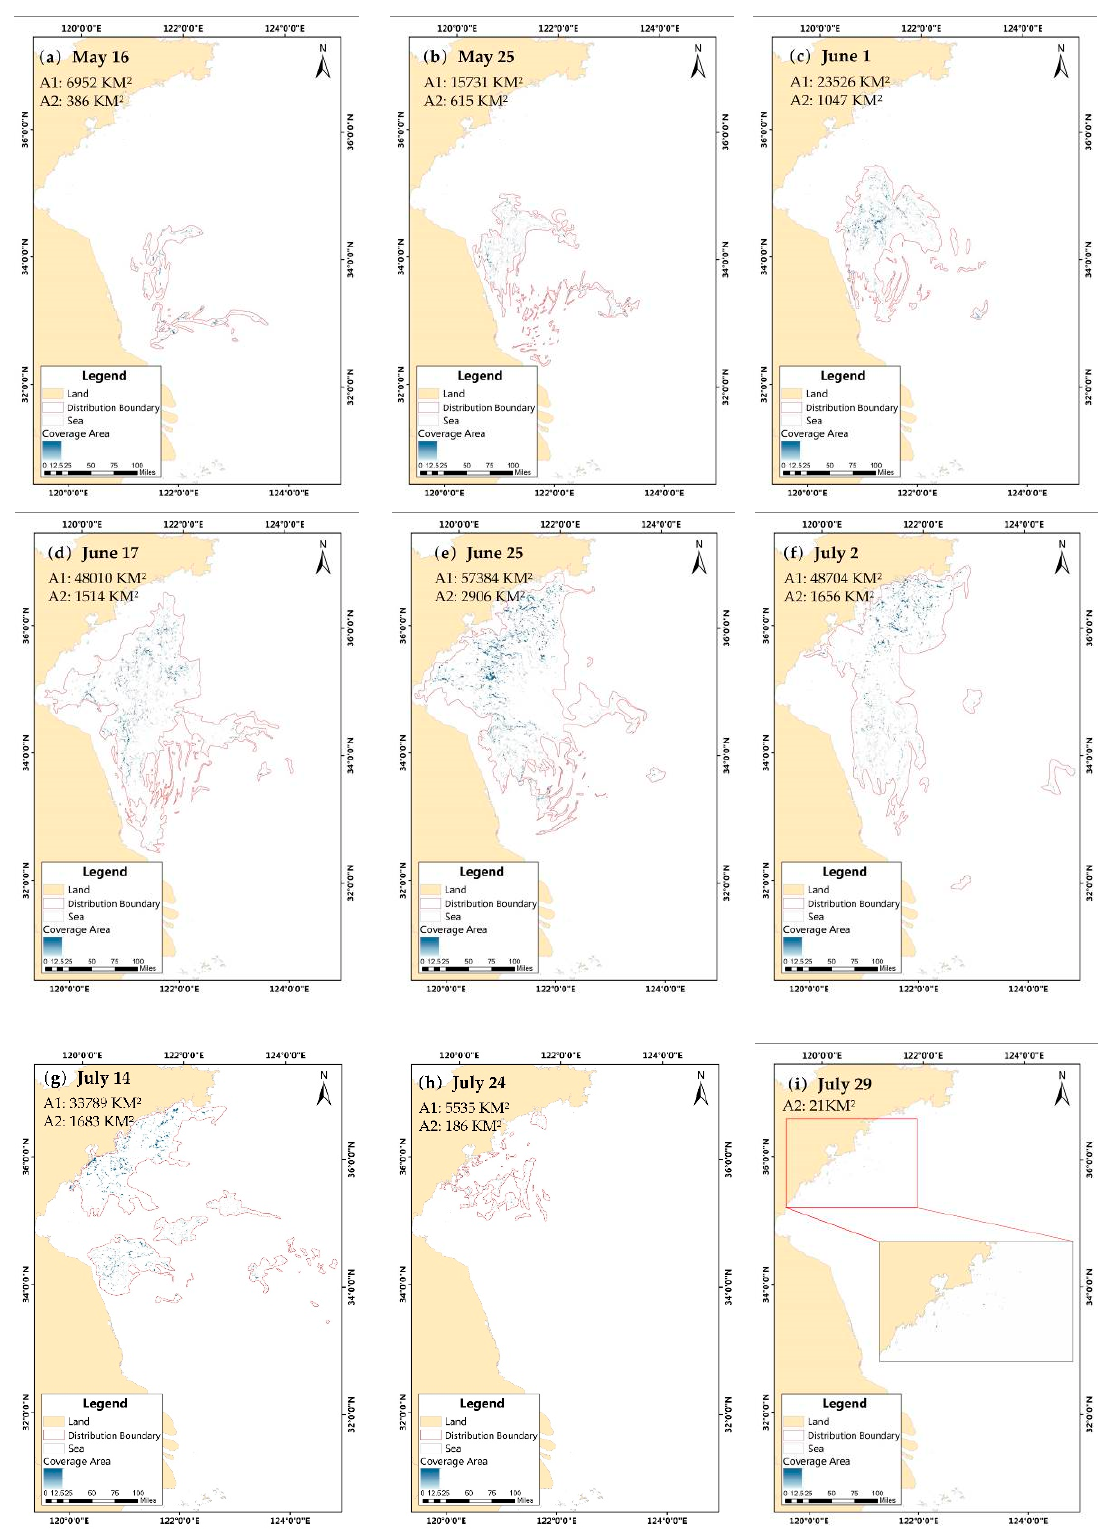
Figure 6. Spatial and temporal distribution of U. prolifera in the Yellow Sea, China in 2016. ( a ) The situation of U. prolifera on May 16. ( b ) The situation of U. prolifera on May 25. ( c ) The situation of U. prolifera on June 1. ( d ) The situation of U. prolifera on June 17. ( e ) The situation of U. prolifera on June 25. ( f ) The situation of U. prolifera on July 2. ( g ) The situation of U. prolifera on July 14. ( h ) The situation of U. prolifera on July 24. ( i ) The situation of U. prolifera on July 29. In image ( i ), only the coverage area of U. prolifera was counted, which existed as only a slender filament. The region in the red box is the coverage of U. prolifera , which is magnified in the detail image below.